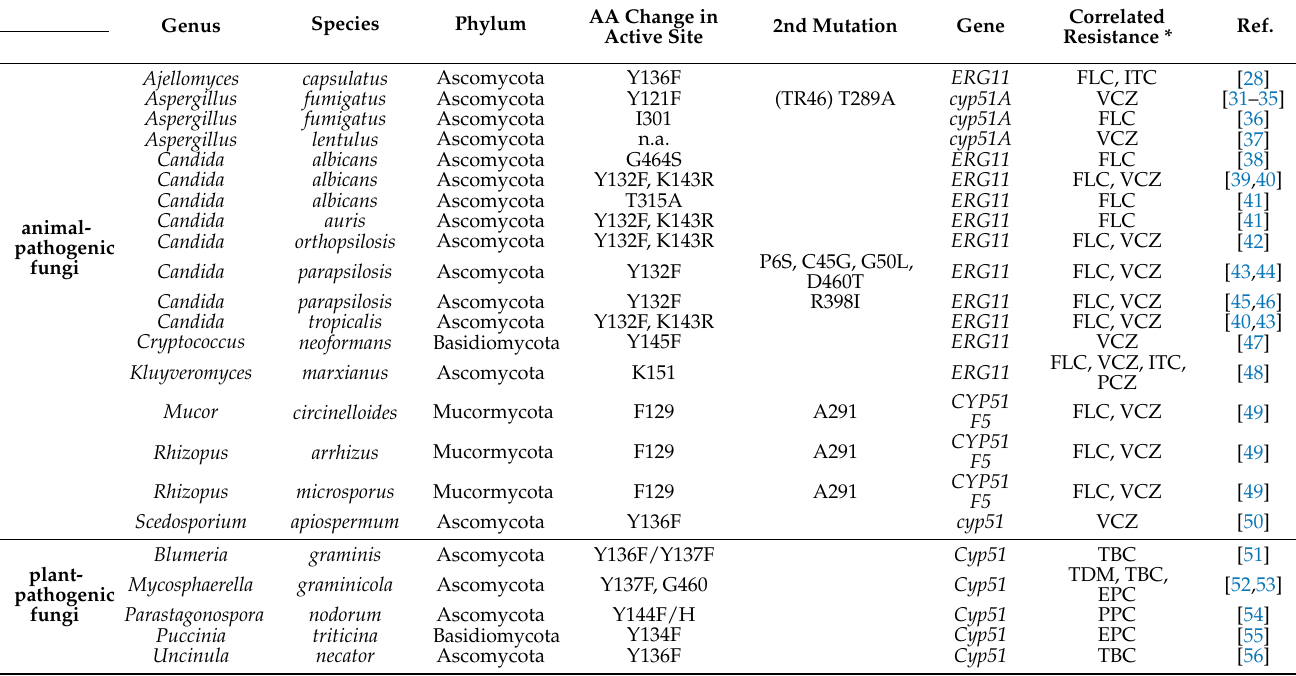
Table 1. Pathogenic fungi with naturally occurring amino acid (AA) substitutions in the active site of sterol 14 α -demethylase (SDM; CYP51 enzyme of the cytochrome P450 superfamily) and correlated azole